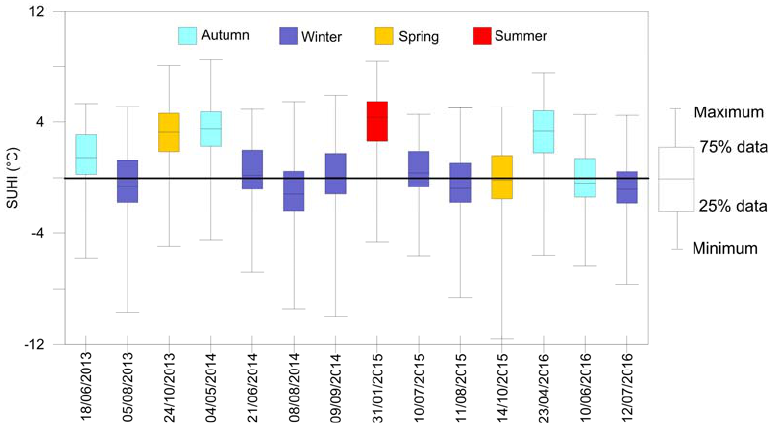
Figure 3. Seasonal bloxplots of the SUHIs.